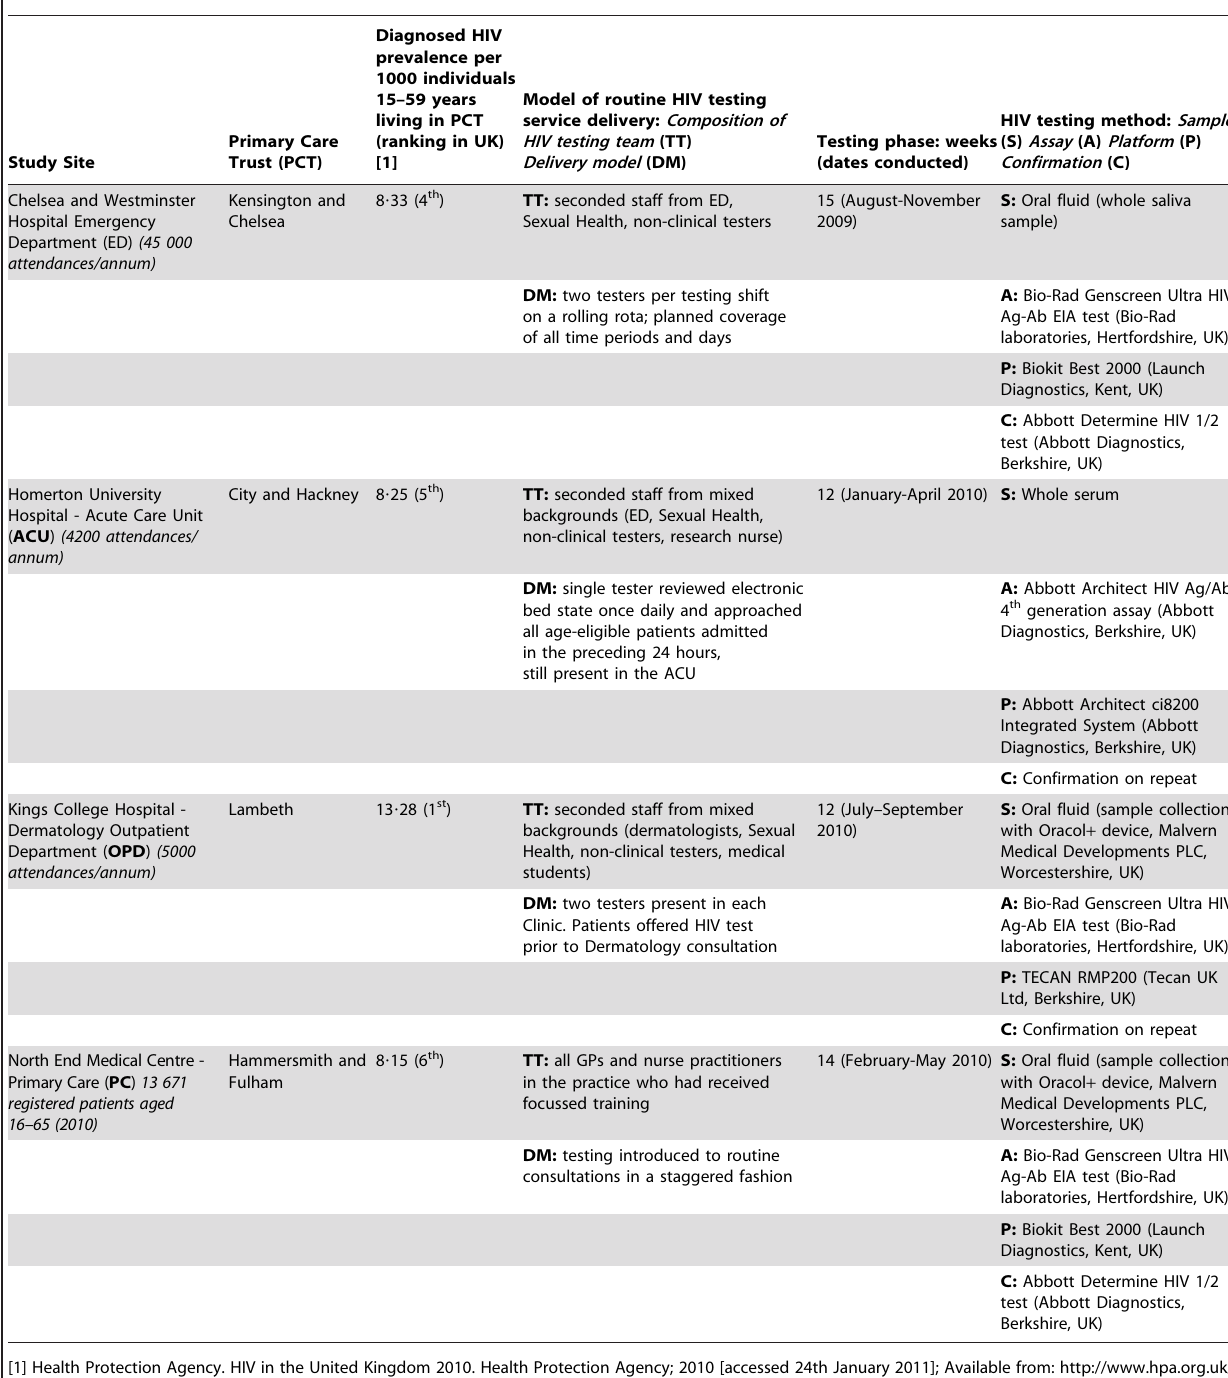
Table 1. HINTS Study